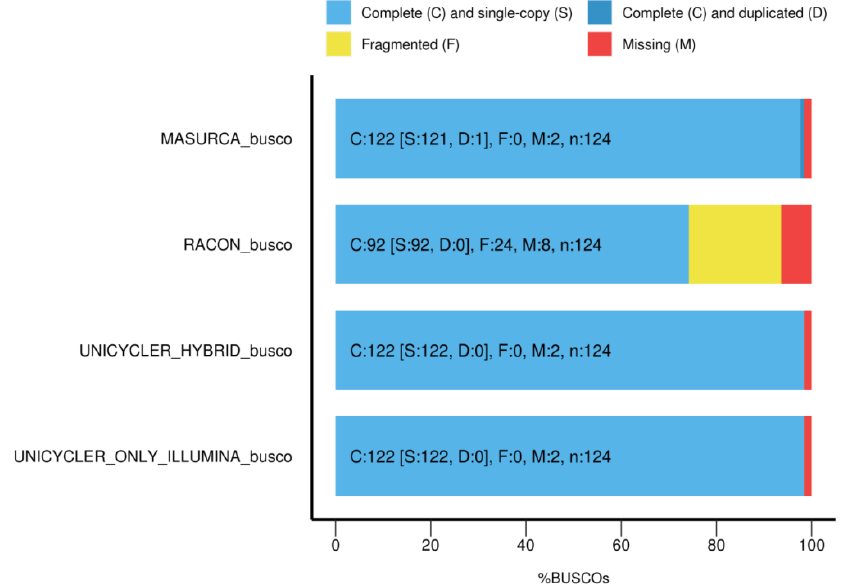
Figure 1. BUSCO completeness assessment of Salmonella SE3 genome. Table 3. Completeness assessment of Salmonella SE3 assemblies using BUSCO software.